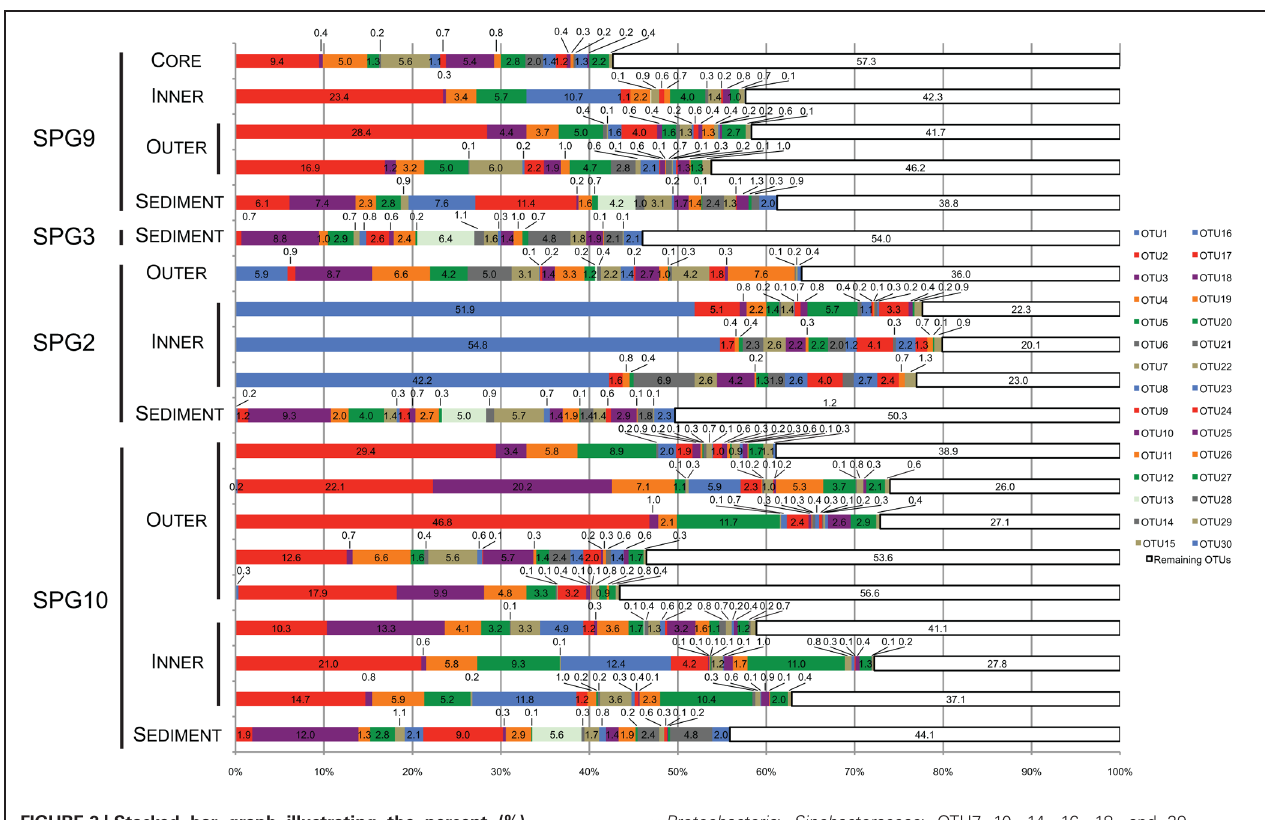
FIGURE 3 | Stacked bar graph illustrating the percent (%) abundance of the 30 most abundant and the value remaining in all other OTUs for all samples. Each of the 30 most abundant OTUs was putatively assigned to the lowest taxonomic level possible. Assignments were as follows: OTU2, 3, 4, 5, 8, 9, 13, 15, 19, 20, 22, 25, 27, 28, and 30, Thaumarchaea MG-1; OTU7, 14, 16, 18, and 29,